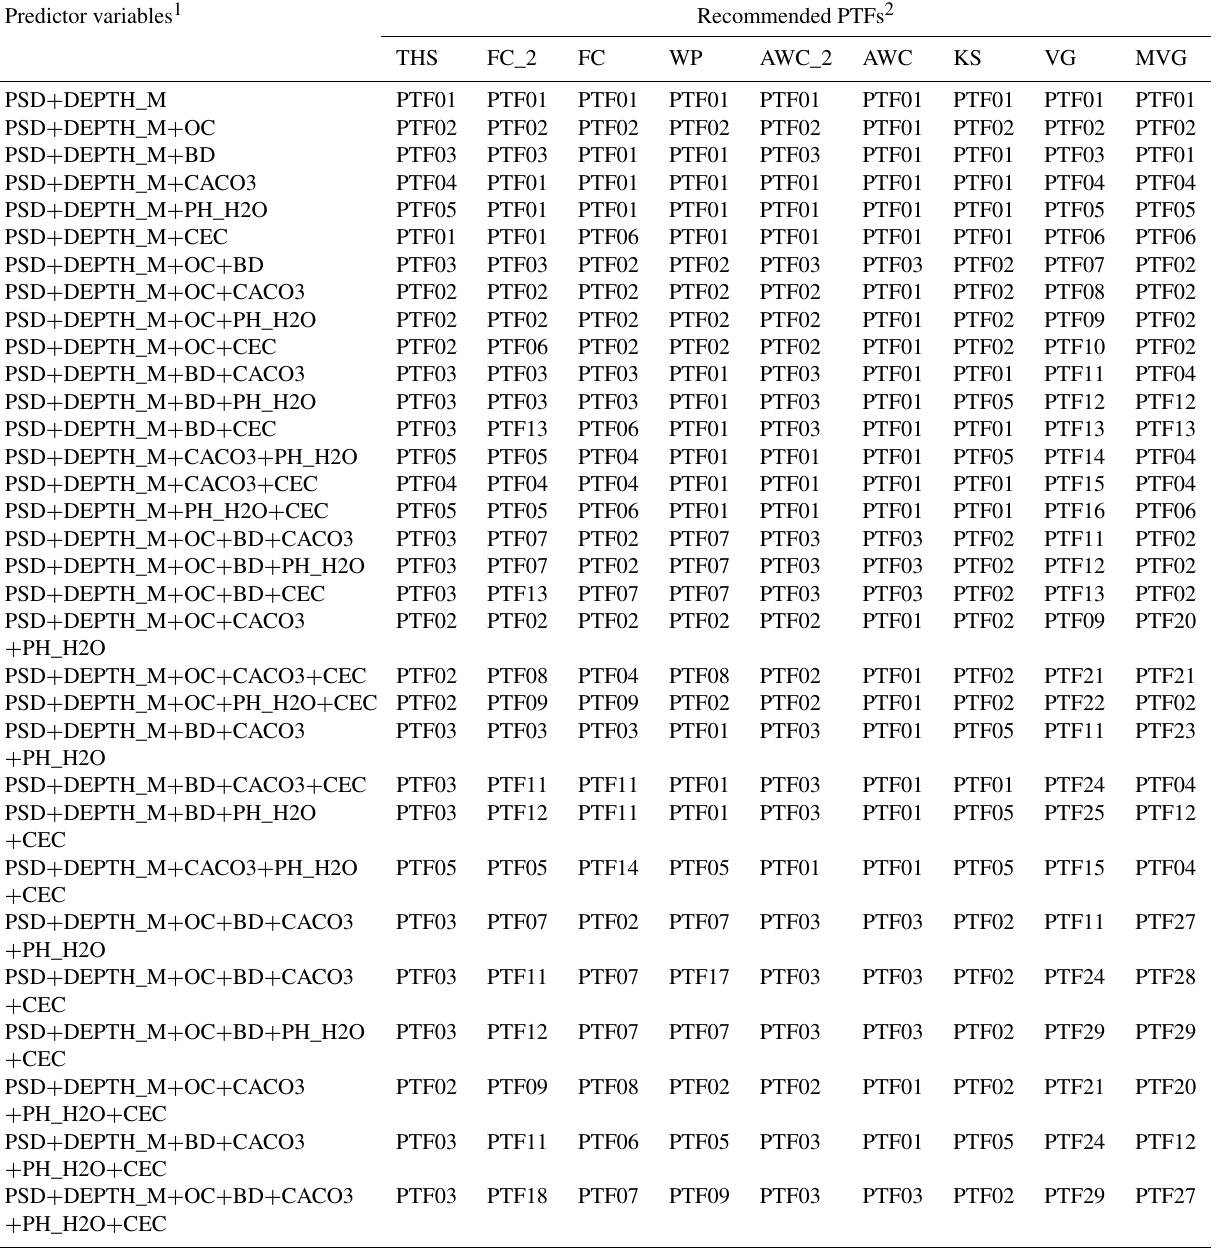
Table 11. List of recommended pedotransfer functions (PTFs) by predicted soil hydraulic property and available predictor variables. Predictor variables